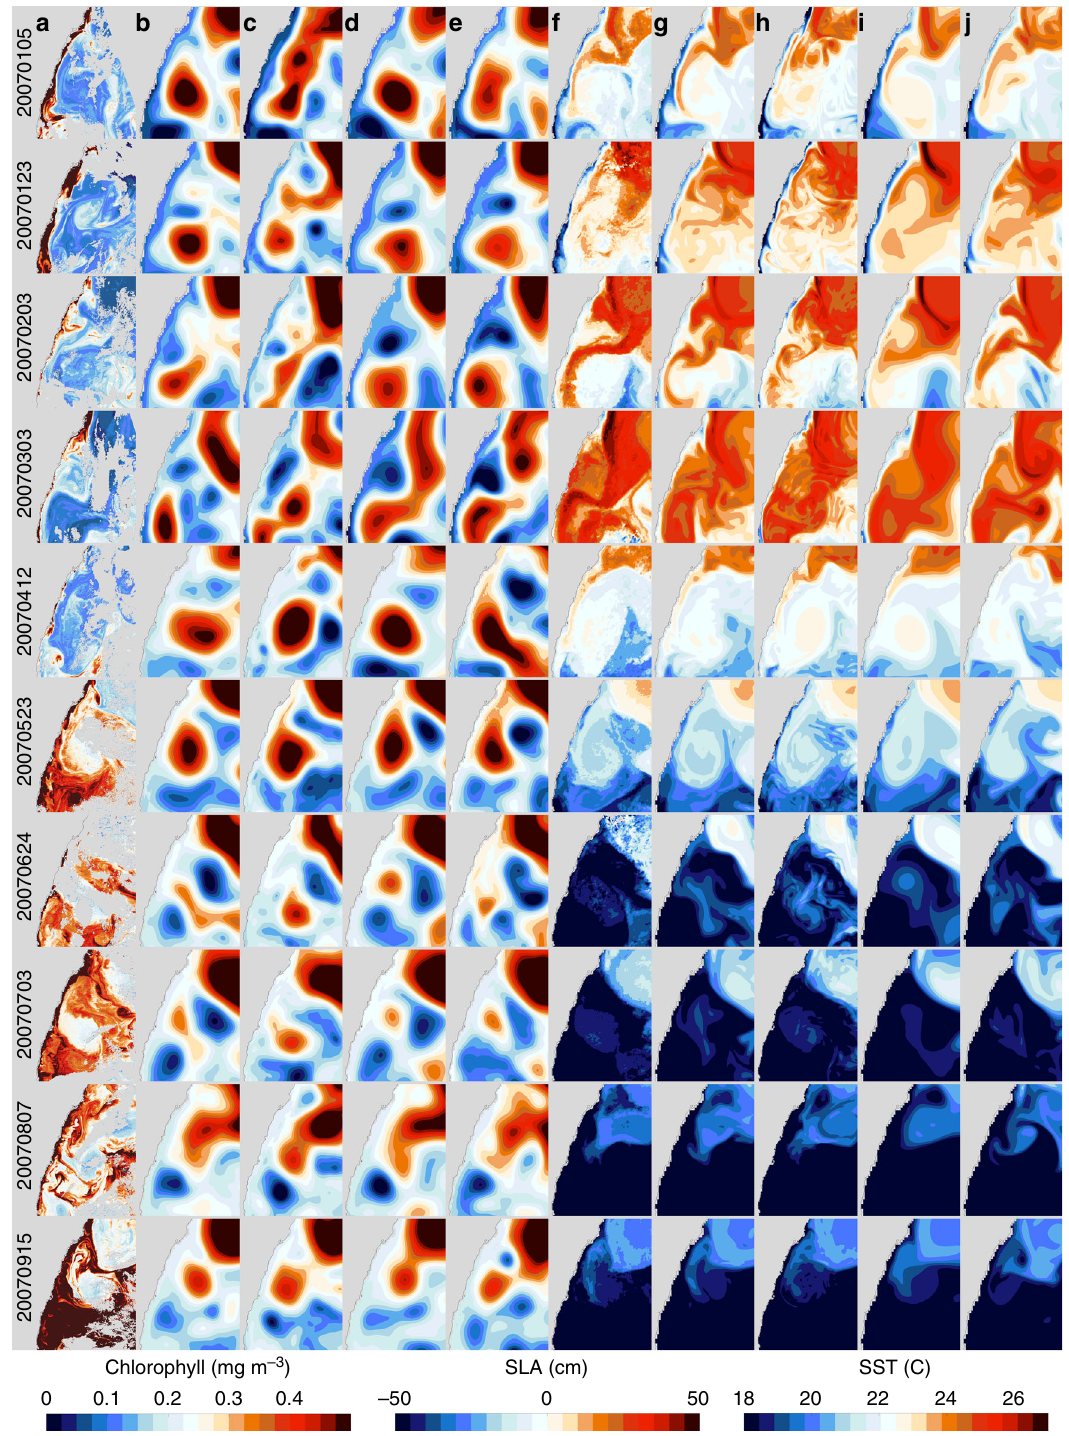
Fig. 3 Daily SLA, SST, AVHRR SST and MODIS chlorophyll- α images on days throughout 2007 when MODIS provides reasonable coverage in the East Australian Current separation region. a MODIS chlorophyll- α concentration, ( b ) 10 km system SLA, ( c ) 2.5 km system SLA, ( d ) EnKF SLA, ( e ) BRAN SLA, ( f ) AVHRR SST, ( g ) 10 km system SST, ( h ) 2.5 km system SST, ( i ) EnKF SST and ( j ) BRAN SST. Sea level anomaly (SLA), sea surface temperature (SST), advanced very-high resolution radiometer (AVHRR), moderate resolution imaging spectroradiometer (MODIS), ensemble Kalman fi lter (EnKF),